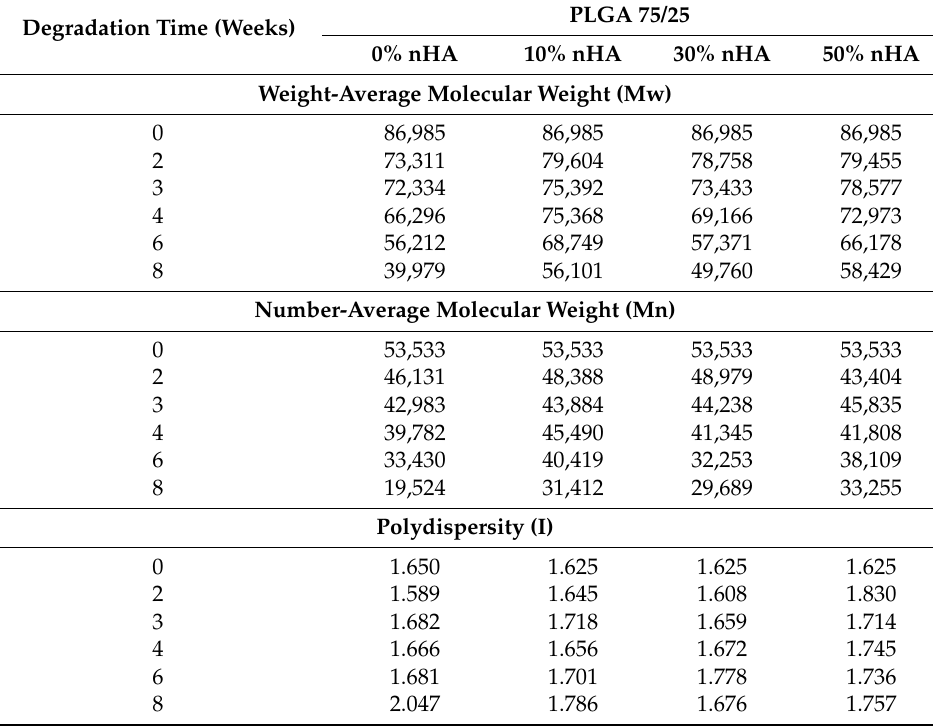
Table 2. Mw, Mn and I as a function of degradation time for PLGA (75/25) and PLGA (75/25)/nHA composite